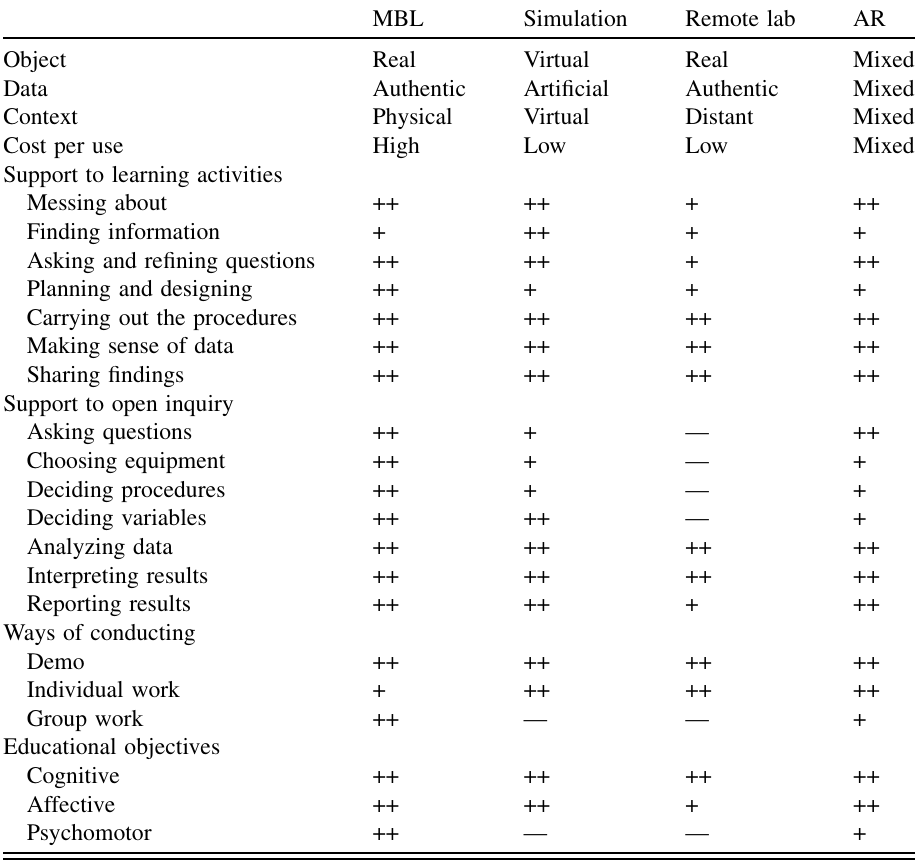
TABLE II. Features of different technologies in physics laboratories. ++, great potential; +, potential with some limitations; —, less